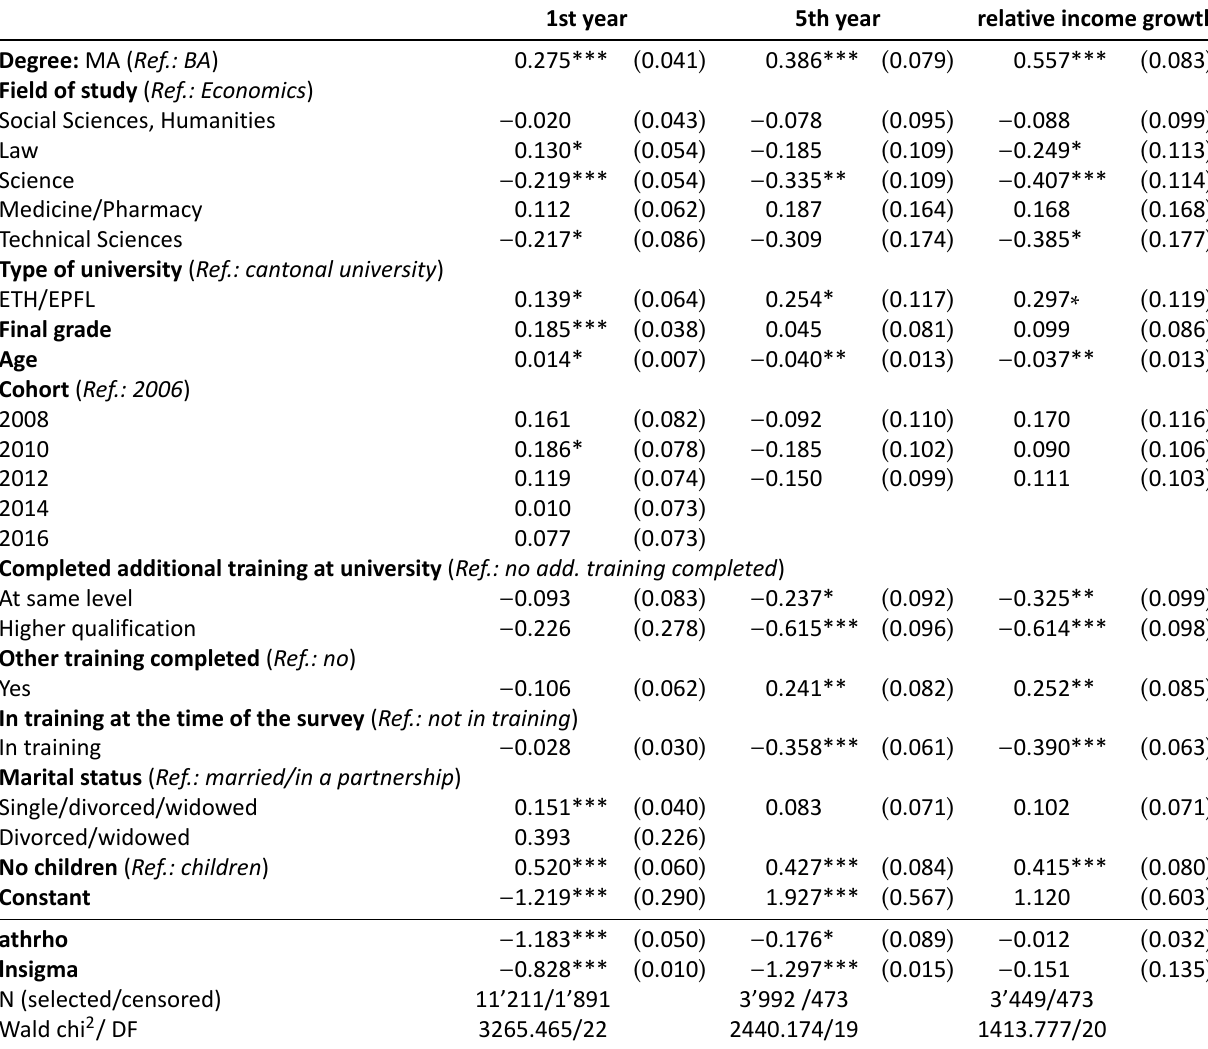
Table A4. Women’s monthly income (log.) in the first and fifth year after graduation and relative income growth, results of selection equations for Table